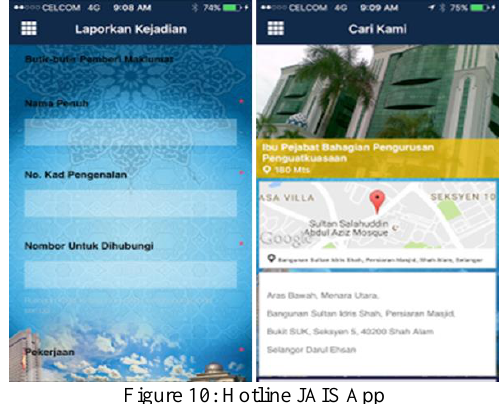
Figure 10: Hotline JAIS